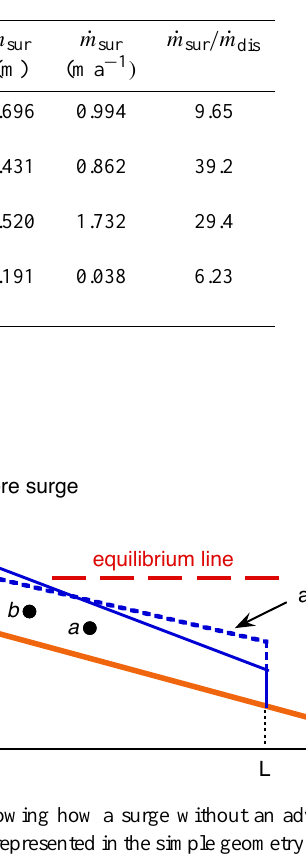
Table 2. Estimated melt rates for four surging glaciers. In the first four columns some characteristics are given. Note that the mean slope of these glaciers differs widely. In the last column, the dissipative melt rate due to surging is compared to the dissipative melt rate implied by the regular mass turnover. Note that the surging melt rate has the same order of magnitude as the precipitation rate ( ˙ p ann ) . Input data from Kamb et al. (1985) (Variegated Glacier), Björnsson et al. (2003) (Tungnaárjökull and Leirufjarjökull), Melvold and Hagen (1998) (Kongsvegen).